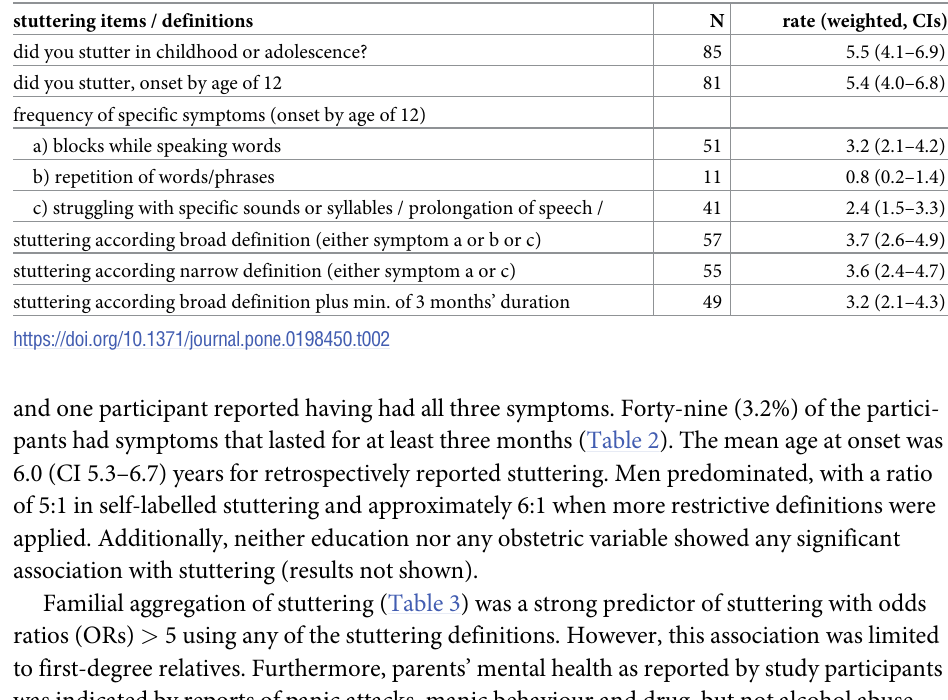
Table 2. ZInEP: Frequencies and prevalence rates of stuttering according to different definitions.